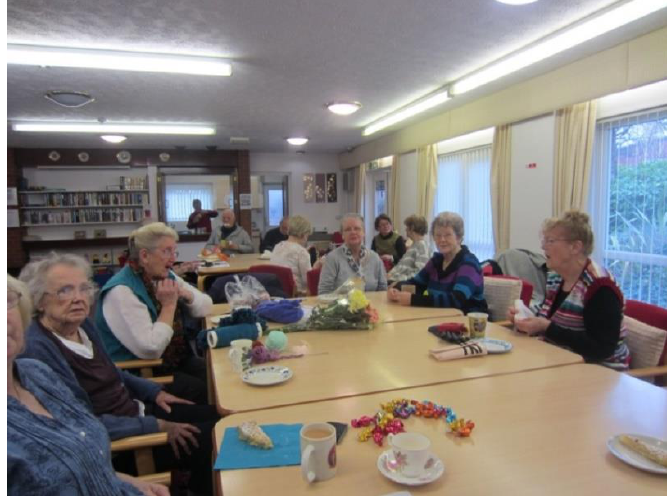
Figure 15. Example of a community group promoting respect and social inclusion (P22) (community group, Liverpool).